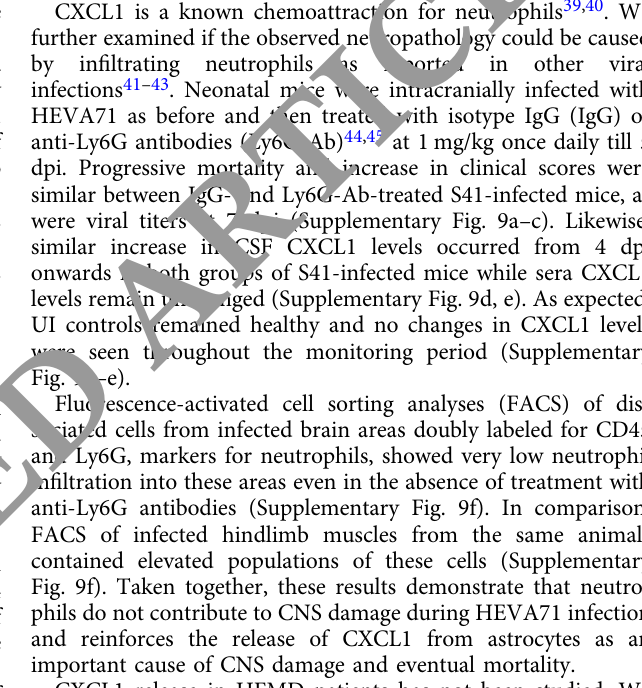
Fig. 1 Productive infection of primary neuronal cultures with HEVA71 causes neuronal cell death. a Immunostaining of UI-, S41- or C2-infected DIV7 neuronal cultures with antibodies against dsRNA and Tau. Scale bars represent 20 µ m. Arrowheads indicated dsRNA-positive neurons. b Quanti fi cation of dsRNA-positive cells in infected DIV7 neuronal cultures at 6 hpi. Two hundred cells taken from random fi elds were manually counted for each condition. Percentages of dsRNA-positive cells were highest in S41- or C2-infected neurons but almost negligible in UI-infected controls. c Immunoblotting of cell lysates from S41-infected neuronal cultures for VP0 and VP2. β -actin was used as a loading control. VP0 and VP2 bands appeared at 6 hpi and continued to increase over the next 42 h. d Quanti fi cation of progeny viral particles release into supernatants of S41- or C2-infected neuronal cultures, where maximal viral titers were detected at 24 hpi in DIV7 neuronal cultures. Peak viral titers were similar in both infected neuronal cultures and RD. e Apoptotic percentages of caspase 3- or TUNEL-positive cells were highest in S41- or C2-infected neuronal cultures that were similar to the positive